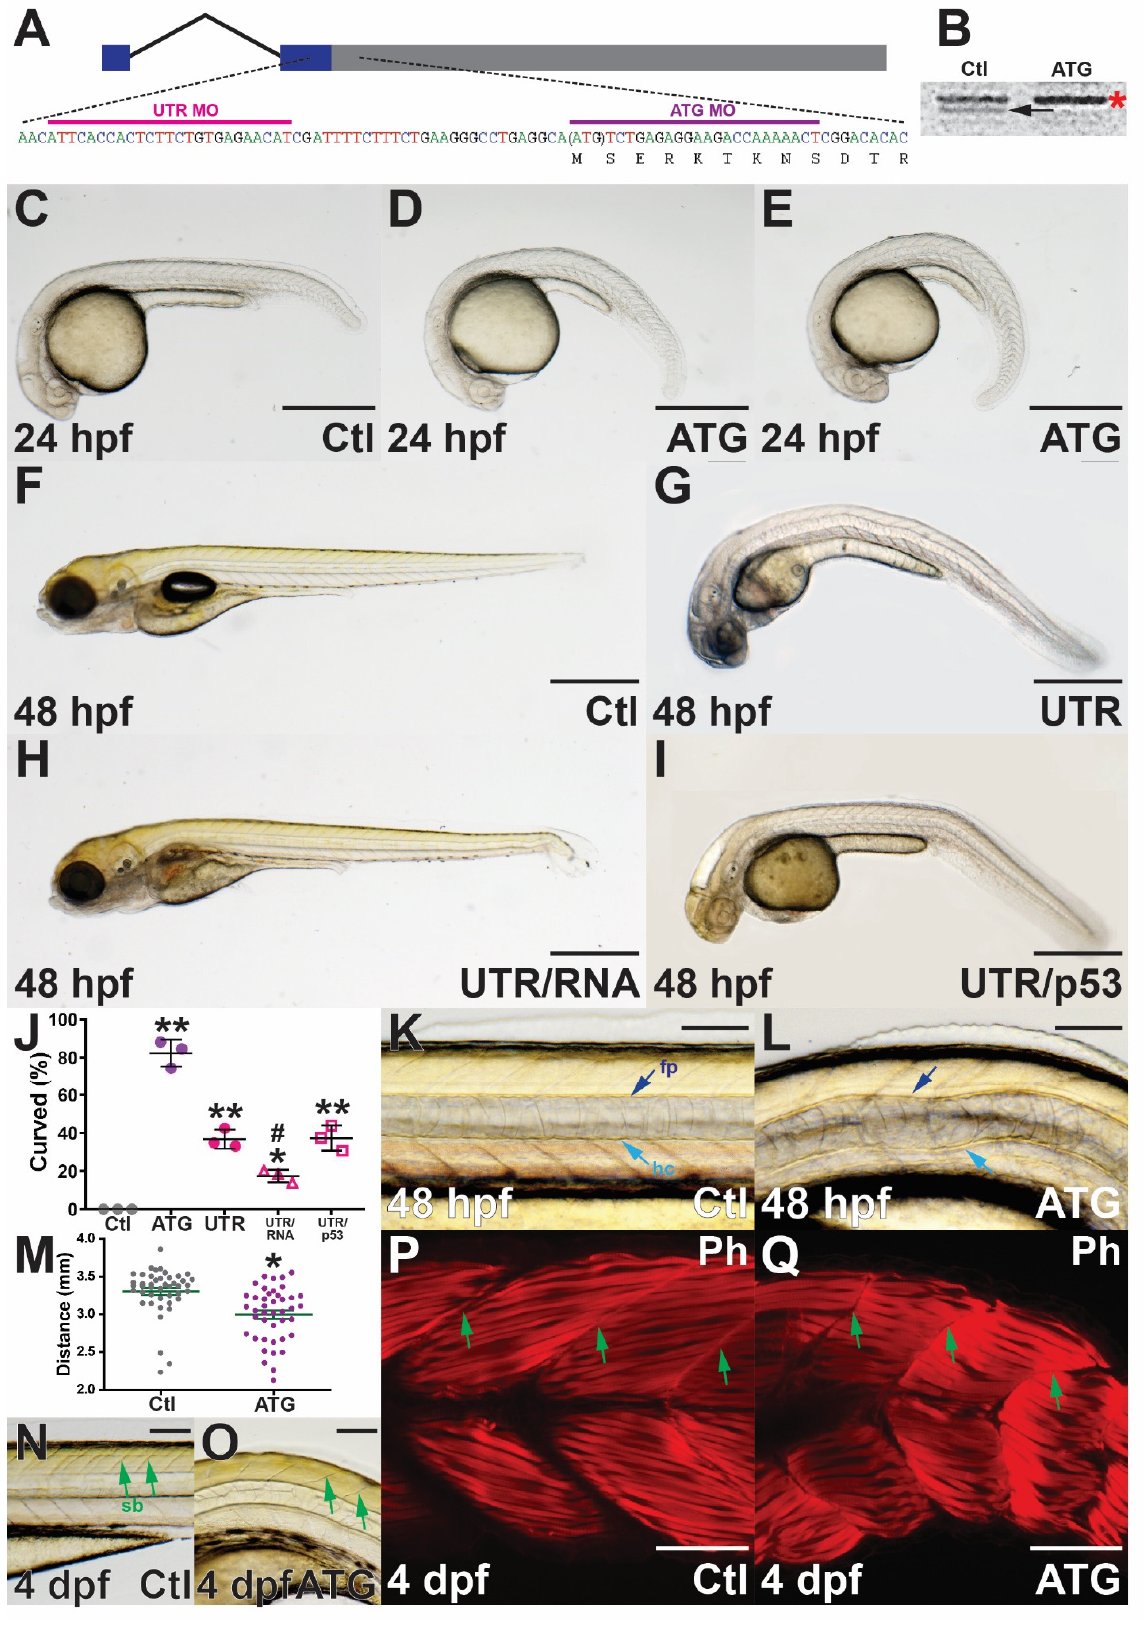
Figure 2. Phenotypic consequences of socs4a knockdown. Schematic of socs4a mRNA schematic showing exons boxed and joined by a thin line, with non-coding sequence in blue and coding in